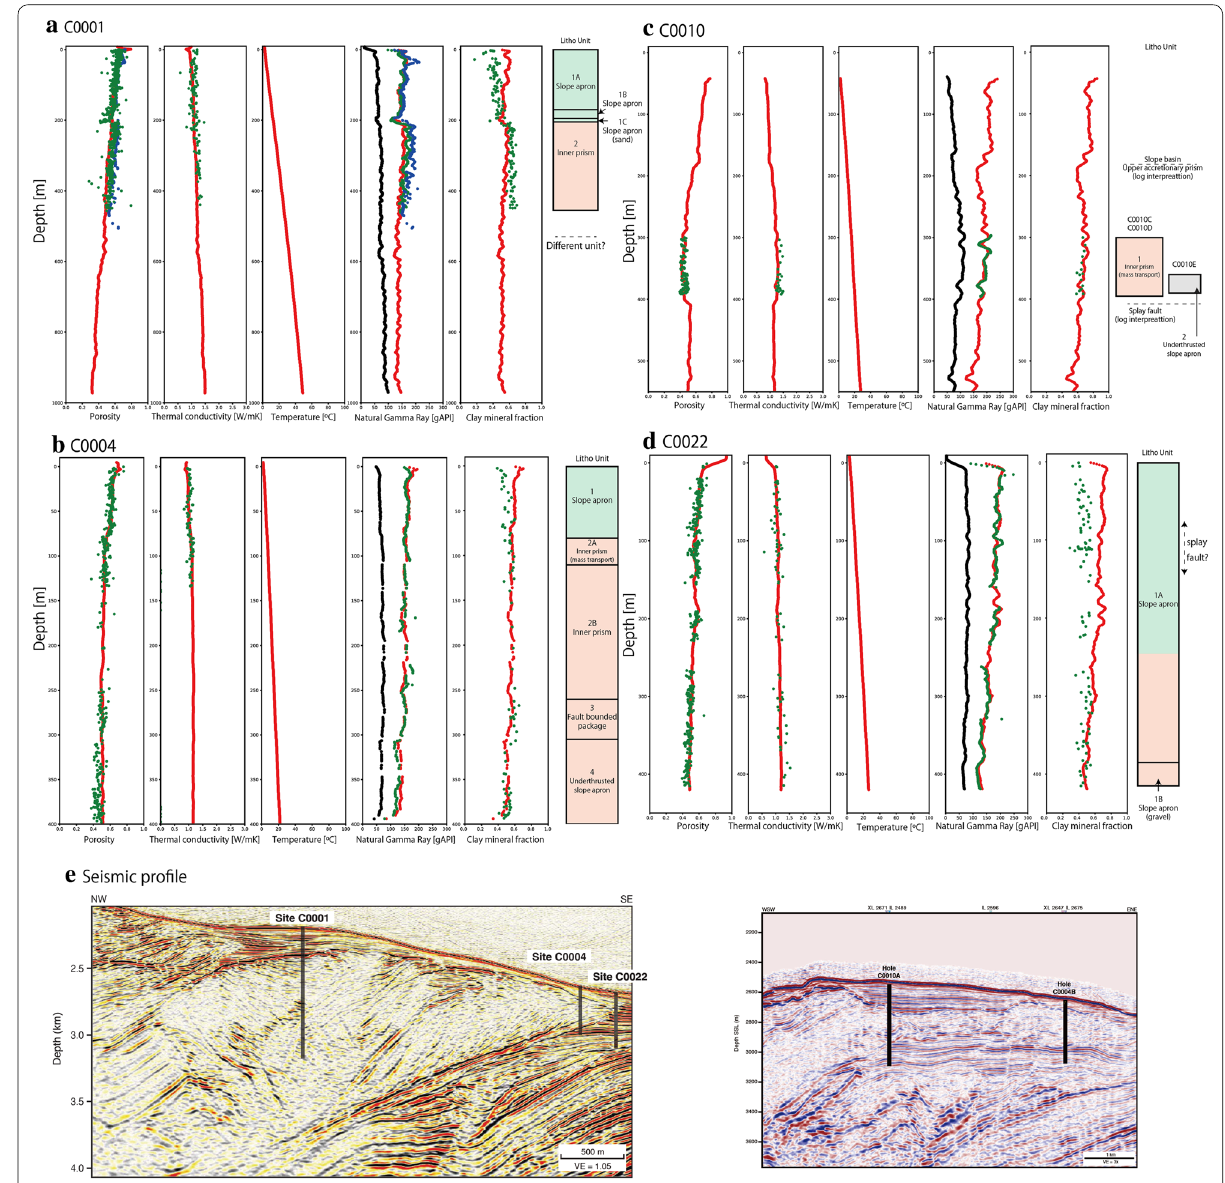
Fig. 5 Data from the outer ridge sites. a Site C0001, b site C0004, c site C0010, d site C0022, and e a seismic profile around the outer ridge (left) after Figure F9A of Tobin et al. (2009) and (right) Figure F30 of Expedition 319 Scientists (2010c). The latter profile is taken in the along-trench direction. Symbols are the same as in Fig. 2. In addition to the symbols explained in Fig. 2, the blue symbols in the porosity plot show the porosities calculated from the density logs. Blue symbols in the NGR plot represent the NGR normalized using the density log-derived